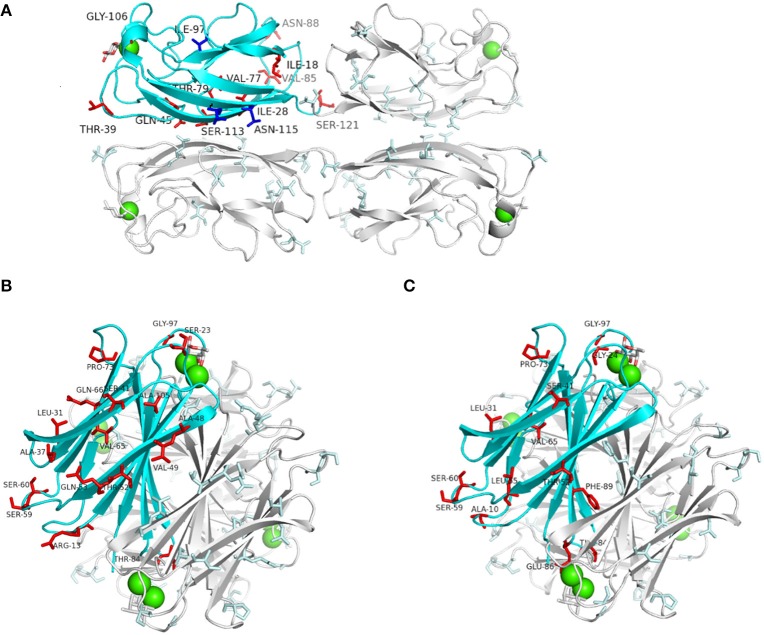
Predicted incidence of amino acids changes on LecAPAO1 and LecBPAO1 crystal structures co-crystallized with galactose (LecA: code 1OKO) and fucose (LecB: code 1GZT). One protein monomer in each structure of LecA and LecB is represented by a blue ribbon. Calcium ions are represented as green spheres, and monosaccharides as sticks. (A) LecAPAO1 structure with all amino acids change observed in lineage I (red sticks) and lineage II (blue sticks; Supplementary Figure S1). (B) LecBPAO1structure showing the incidence of the observed amino acids changes among cluster II sequences (Figure 1). (C) LecBPAO1 structure showing the amino acids changes of cluster III sequences (Figure 1). All structural figures were drawn with PyMOL Molecular Graphics System.